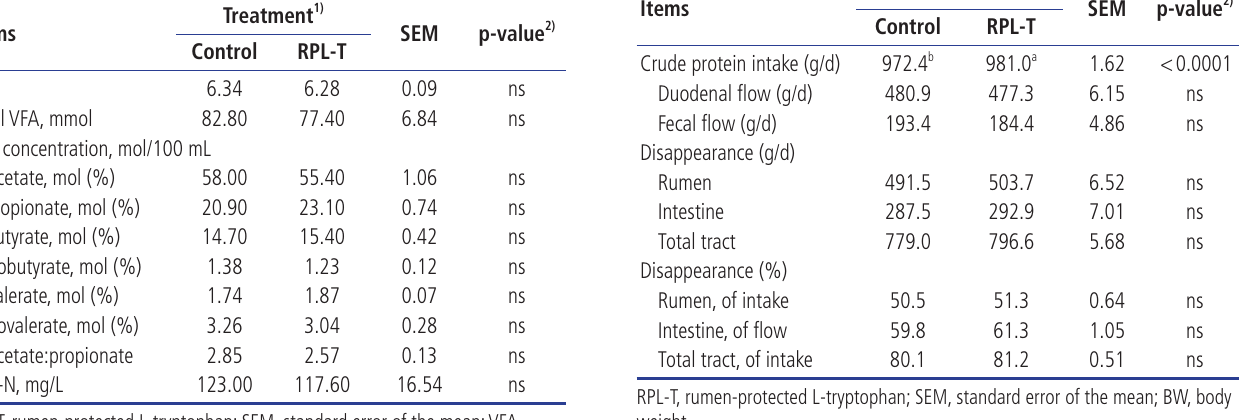
Table 1. Ruminal characteristics in Korean native steers fed basal diet and rumen-protected L-tryptophan (RPL-T) Items